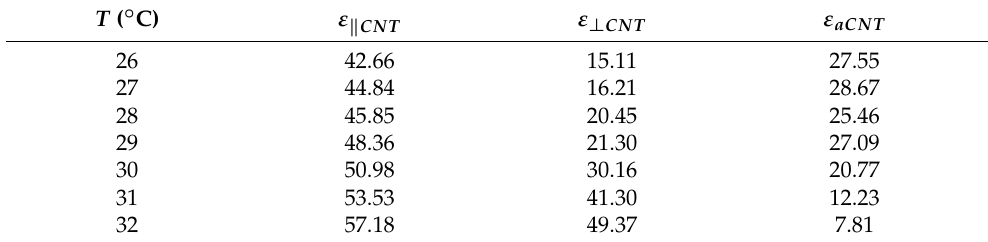
Table 2. Dielectric permittivities and anisotropy for